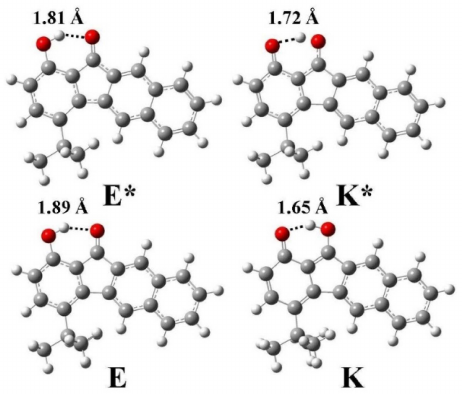
Figure 7. The optimized geometric structures of enol (E) and keto (K) form for 1 in the ground and the first singlet excited state together with the intramolecular hydrogen bond